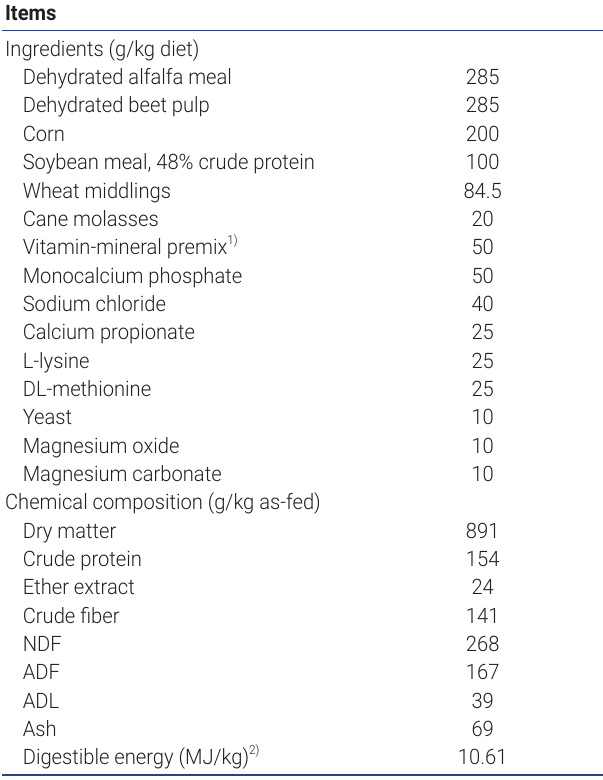
Table 1. Ingredients and chemical composition of the diet fed to rab-